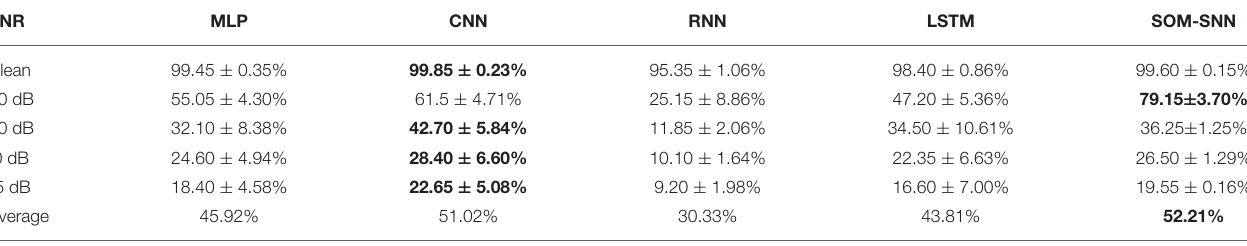
TABLE 3 | Average classification accuracy of different models under the mismatched-condition.